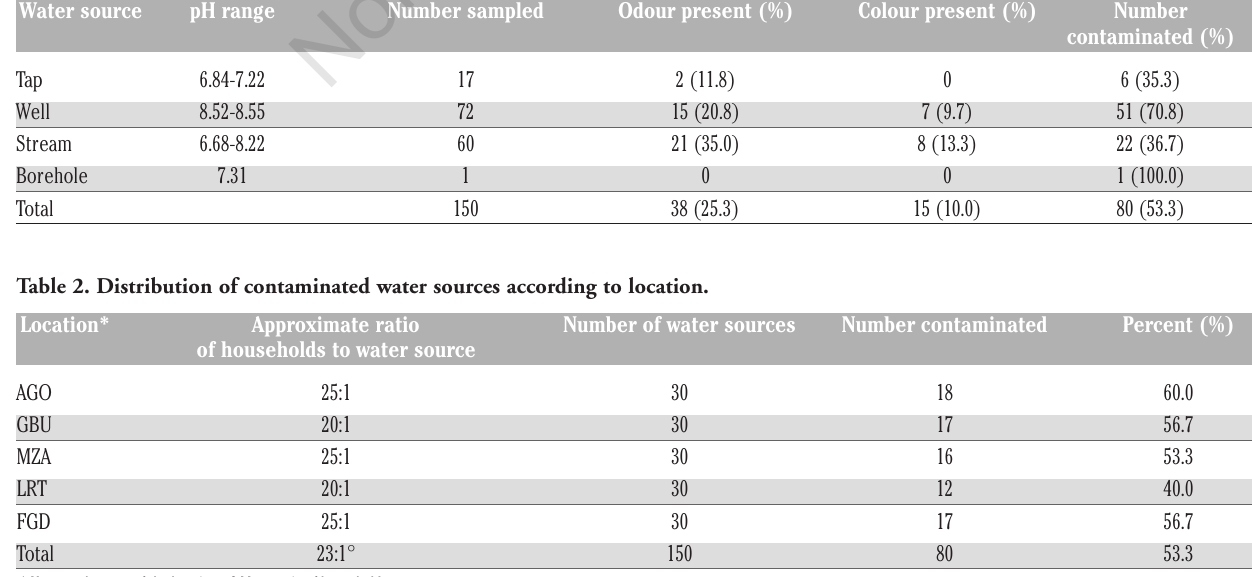
Table 1. Rate of contamination of water sources in the study area. Water source